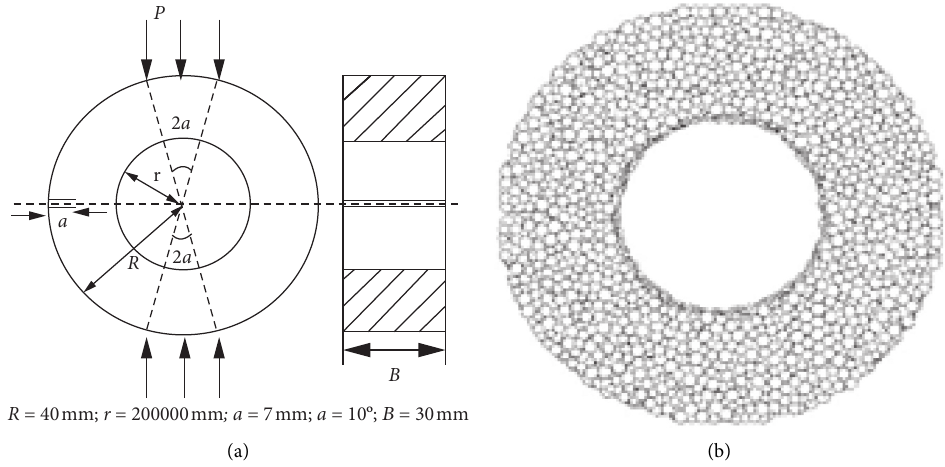
Figure 9: Edge cracked flattened ring model. (a) Model size. (b) PFC 3D model.